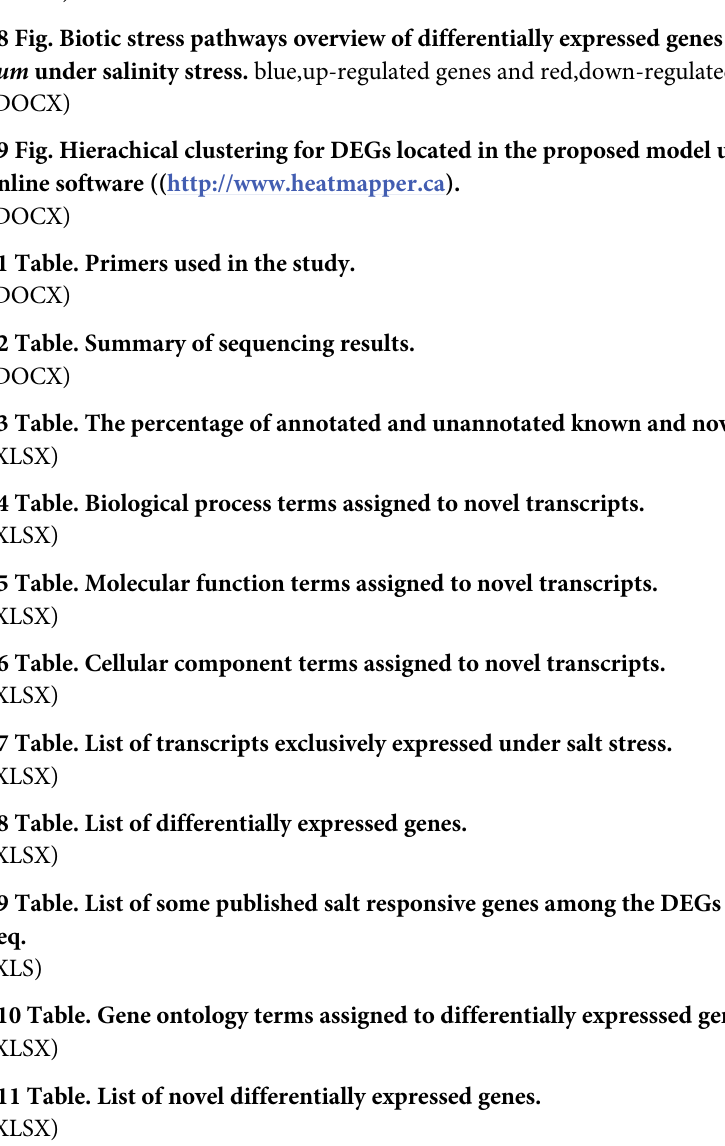
S4 Fig. Alternavive splicing events happened in normal and salt-treated samples. (DOCX) S5 Fig. Gene ontology enrichment for biological process category for the differentially expressed genes having alternative splicing events. S6 Fig. Cellular response pathways overview of differentially expressed genes in Triticum aestivum under salt stress. blue,up-regulated genes and red,down-regulated genes. (DOCX) S7 Fig. Secondary metabolic pathways overview of differentially expressed genes in Triti- cum aestivum under salinity stress. blue,up-regulated genes and red,down-regulated genes. (DOCX) S8 Fig. Biotic stress pathways overview of differentially expressed genes in Triticum aesti- vum under salinity stress. blue,up-regulated genes and red,down-regulated genes. (DOCX) S9 Fig. Hierachical clustering for DEGs located in the proposed model using Heatmapper online software ((http://www.heatmapper.ca). S1 Table. Primers used in the study. S2 Table. Summary of sequencing results. S3 Table. The percentage of annotated and unannotated known and novel transcripts. (XLSX) S4 Table. Biological process terms assigned to novel transcripts. (XLSX) S5 Table. Molecular function terms assigned to novel transcripts. (XLSX) S6 Table. Cellular component terms assigned to novel transcripts. (XLSX) S7 Table. List of transcripts exclusively expressed under salt stress. (XLSX) S8 Table. List of differentially expressed genes. (XLSX) S9 Table. List of some published salt responsive genes among the DEGs detected by RNA- Seq. S10 Table. Gene ontology terms assigned to differentially expresssed genes. S11 Table. List of novel differentially expressed genes.